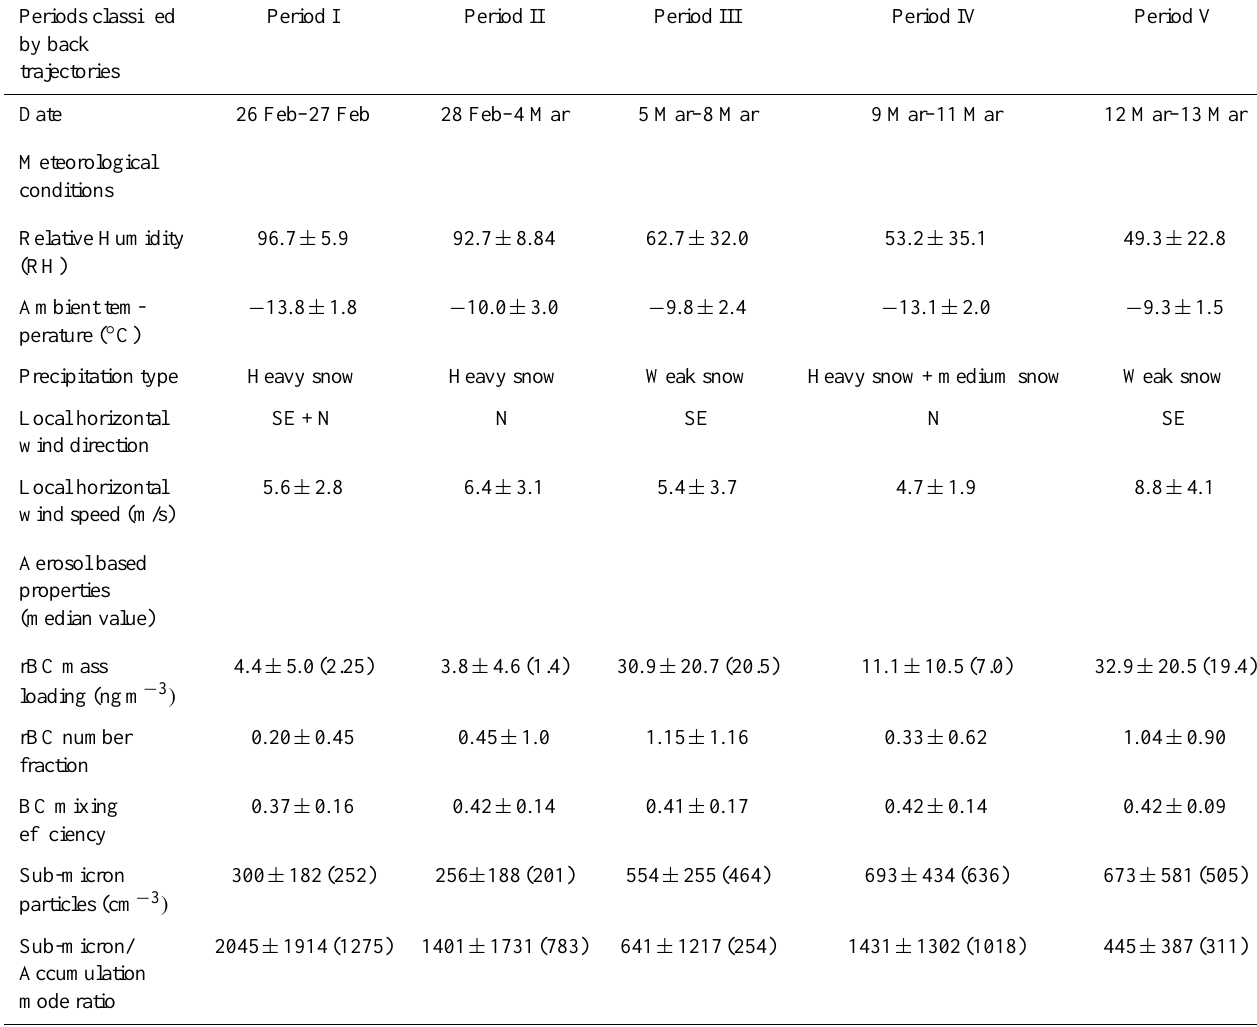
Table 2. A summary of meteorological conditions and aerosol properties categorized by five periods classified by back trajectory analysis (Fig. 1, A1–A5). The mean and standard deviations are shown for each parameter and the number in brackets is median